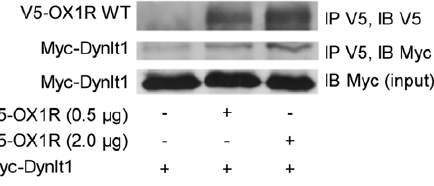
Figure 2. Interaction of OX1R and Dynlt1 in mammalian cells. HEK293 cells were transfected with expression vectors for Myc-Dynlt1 and V5-OX1R (0.5 or 2.0 m g DNA, full-length receptor) or corresponding empty vector. Whole-cell lysates were subjected to IP using an anti-V5 antibody and protein G-sepharose beads, followed by IB with anti-V5 or anti-Myc antibodies against V5-OX1R and Myc-Dynlt1, respectively. Equal transfection of Myc-Dynlt1 was verified by IB with anti-Myc antibody on cell extracts (input). The experiment was repeated 5 times, with similar results.